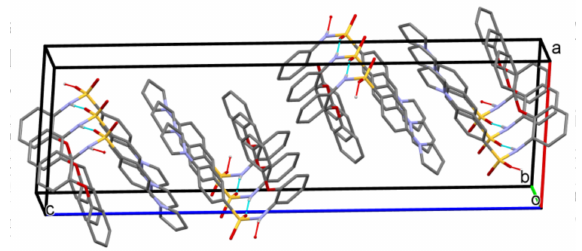
Figure 5. Crystal packing diagram for 25 , hydrogen atoms